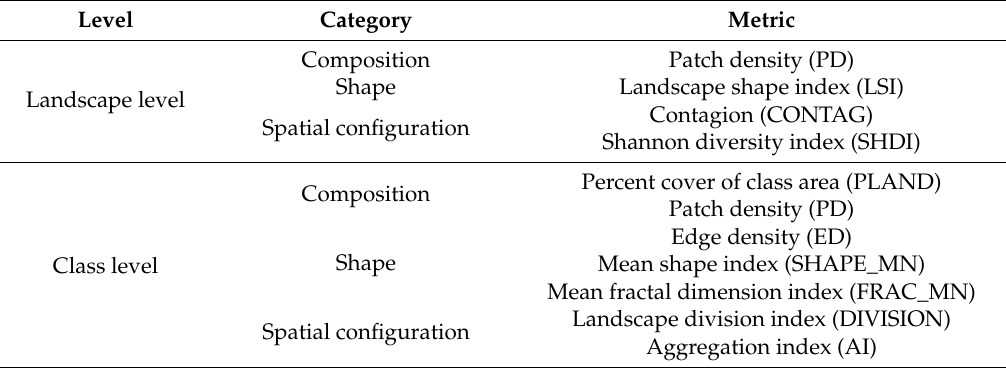
Table 3. The list of landscape pattern metrics